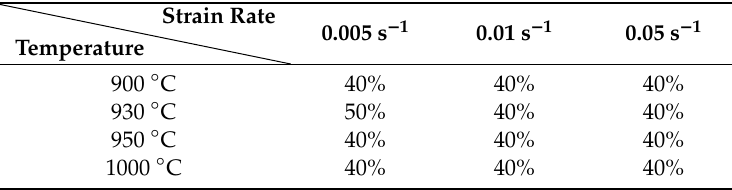
Table 1. Isothermal hot compression test